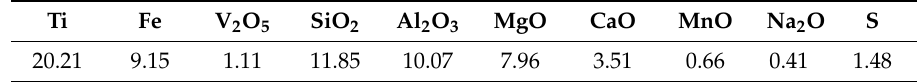
Table 6. Chemical compositions of the rough TiN concentrate (wt %), as determined by XRF analysis.